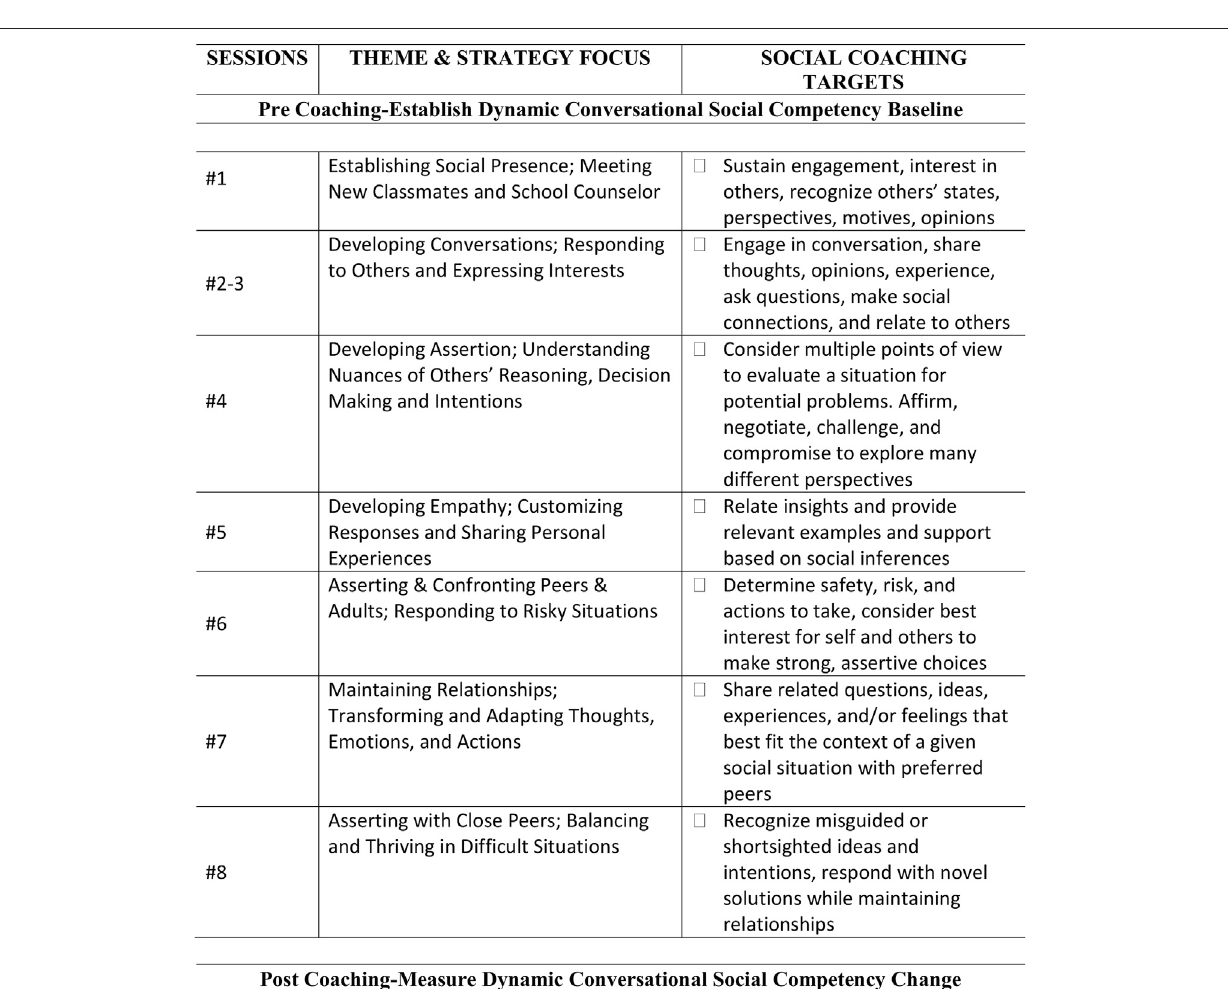
FIGURE 2 | Virtual social training session design.